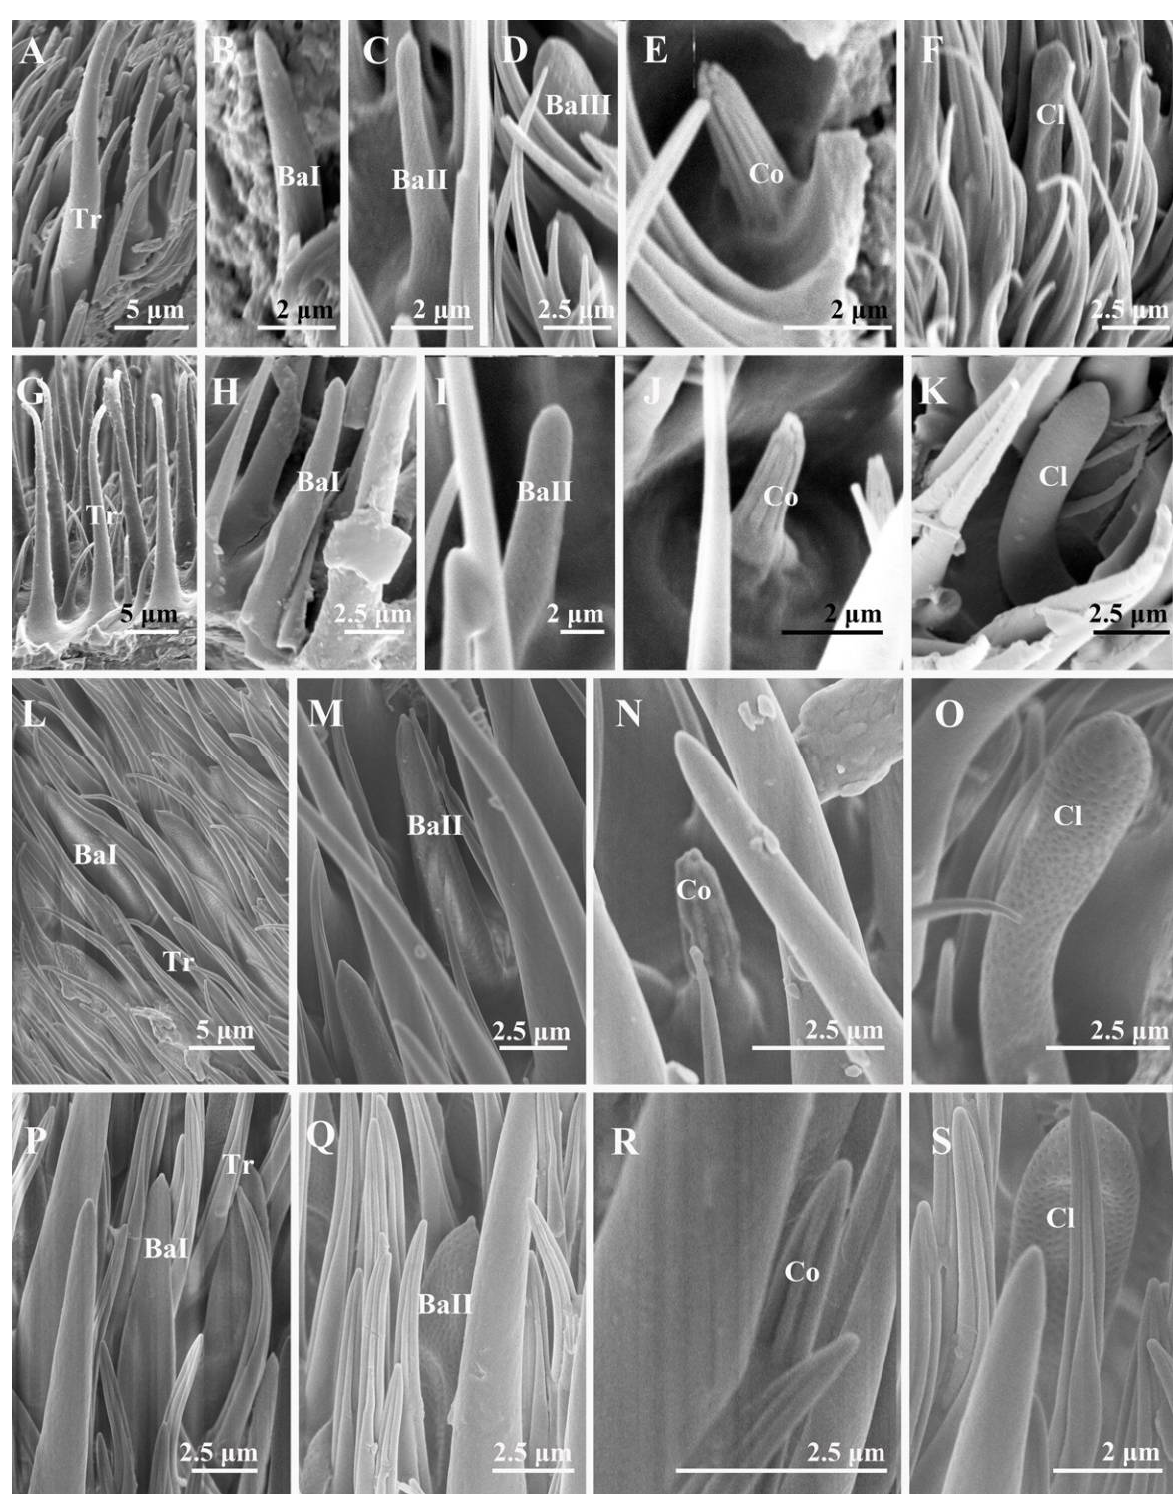
Figure 5. Trichoid sensilla, basiconic sensilla, coeloconic sensilla, and clavate sensilla on the antennal postpedicel of male sarcophagid species. ( A – F ) A . mihalyii ; ( G – K ) M . campestris ; ( L – O ) M . mesomelaena ; ( P – S ) W . bella . Abbreviations: Co (coeloconic sensilla); Cl (clavate sensilla); Ba I (subtype I basiconic sensilla); Ba II (subtype II basiconic sensilla); Ba III (subtype III basiconic sensilla); Tr (trichoid sensilla).